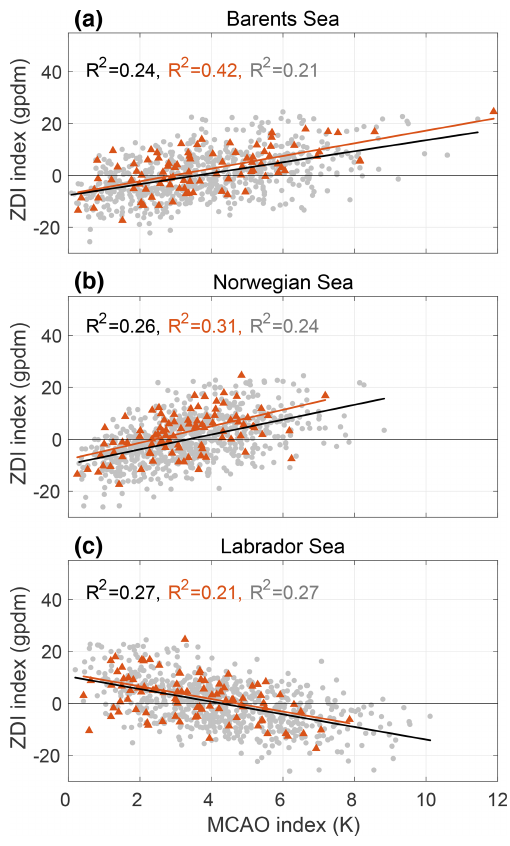
Figure 3. The relation between the weekly averaged ZDI in- dex (gpdm) and the weekly MCAO index (K) over (a) the Barents Sea, (b) the Norwegian Sea and (c) the Labrador Sea during DJFM in ERA-Interim. Weekly averages within a 30d period after SSW events are shown as orange triangles, and weekly averages in DJFM between 1979 and 2019 (climatology) are marked by grey circles. Linear regression fit with corresponding R 2 coefficient is computed for the climatology (black) and periods following SSW events (or- ange). For completeness, R 2 for weekly averages that do not in- clude periods after SSW events is shown in grey. All anomalies are computed with respect to the daily climatology. All correlations are statistically significant ( p < 0 .